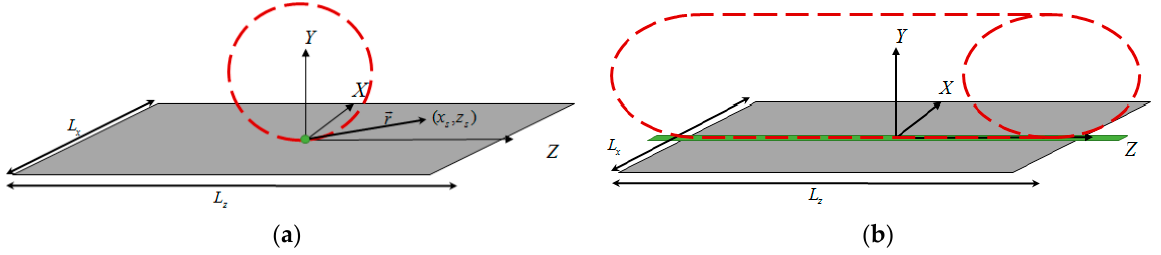
Figure 4. Schematic of the pivot in two positions: ( a ) in the center of the sheet, and ( b ) on the axis passing through the center along the length. The pivot is represented in green.